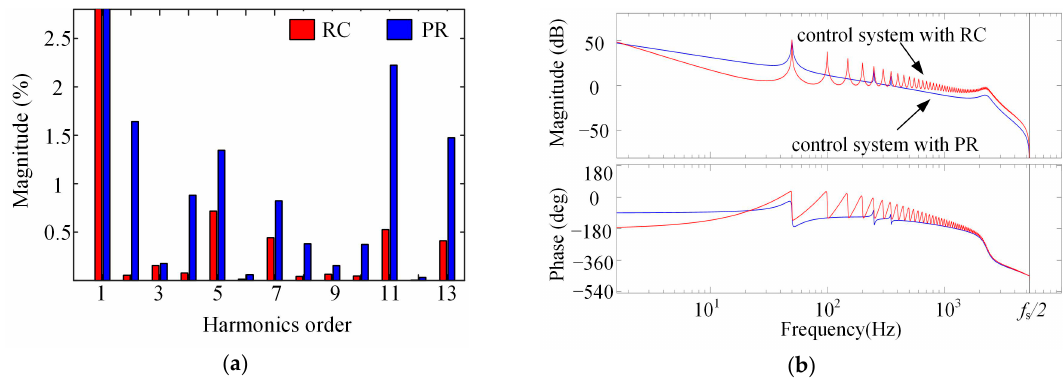
Figure 14. ( a ) Spectra of output current; and ( b ) Bode plots of the control system open-loop gain with different controllers.